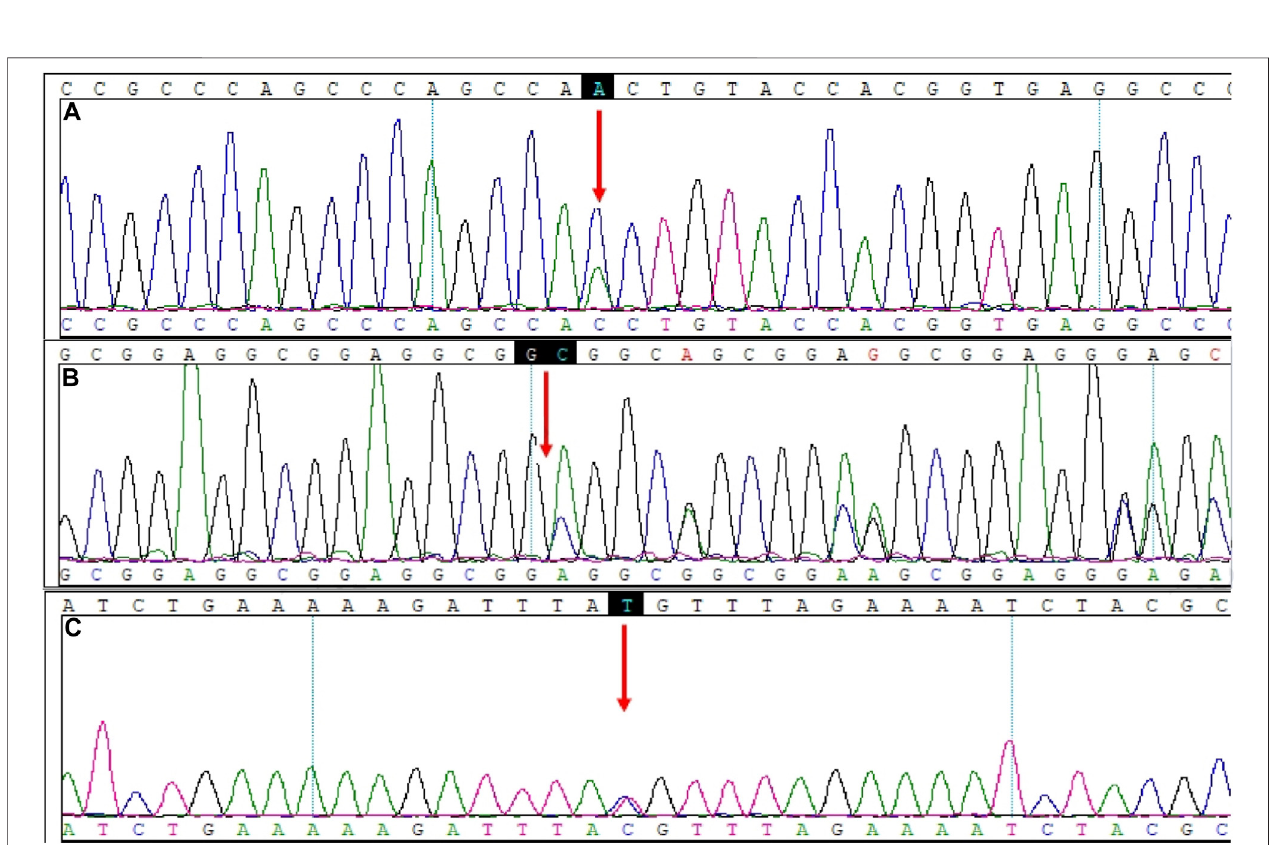
FIGURE 2 | Mutation sites in CNOT3 and PCNT . (A) CNOT3 , NM_014516.3: c.827A > C. (B) CNOT3 , NM_014516.3: c.1202_1203insAGGCGG. (C) PCNT , NM_006031.5: c.1069T > C.